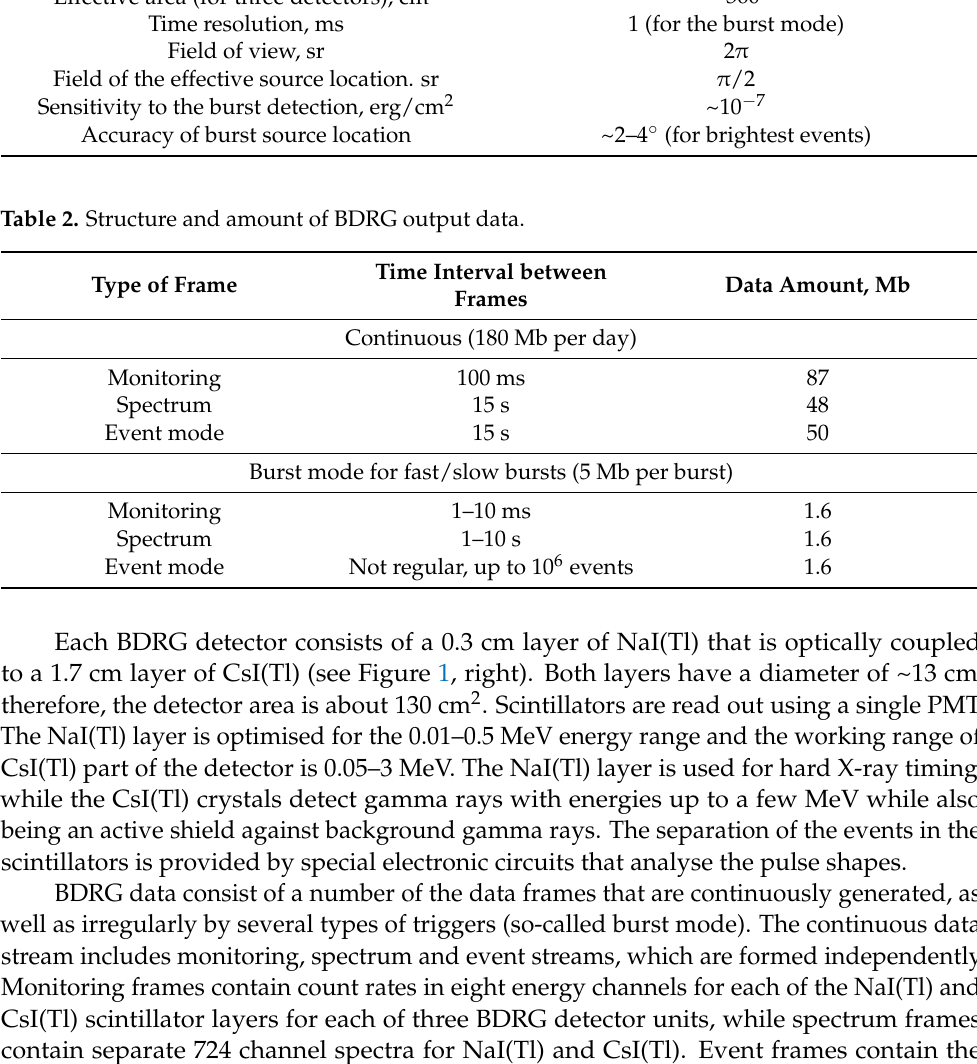
Table 1. Parameters of the BDRG instrument. Parameter, Units Value Energy range, MeV 0.01–3.0 Effective area (for three detectors), cm 2 Time resolution, ms